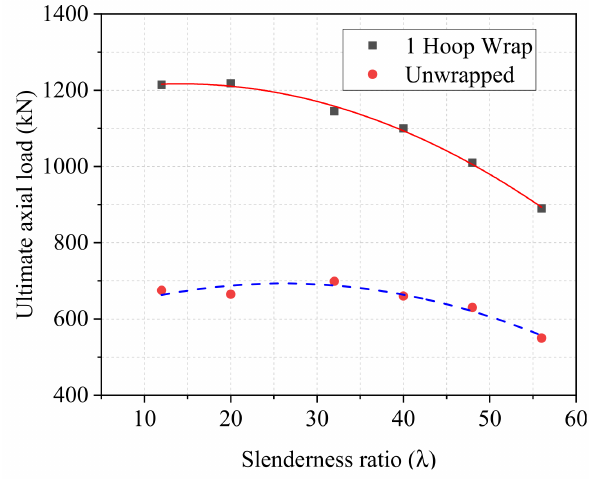
Figure 3. Ultimate axial load versus slenderness ratios relationships.